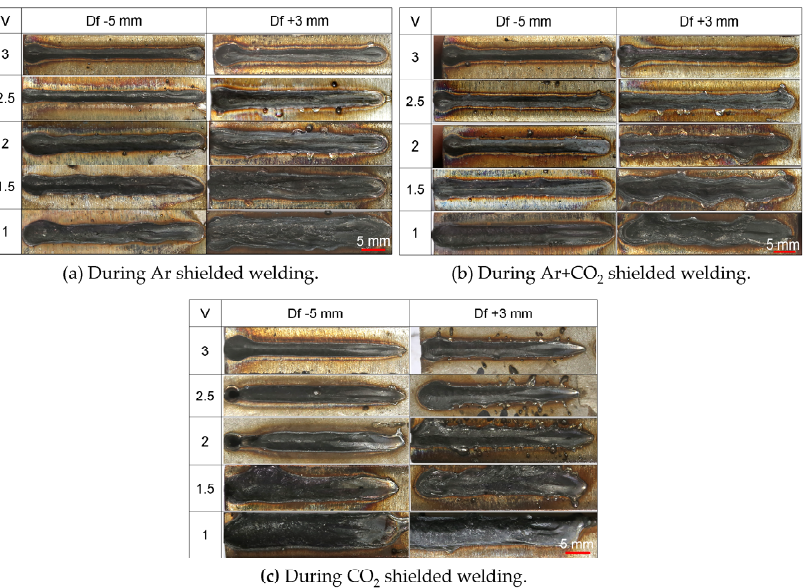
Figure 2. Weld appearances under different shielding gases and V . ( a ) During Ar shielded welding; ( b ) during Ar + CO 2 shielded welding; ( c ) during CO 2 shielded welding.